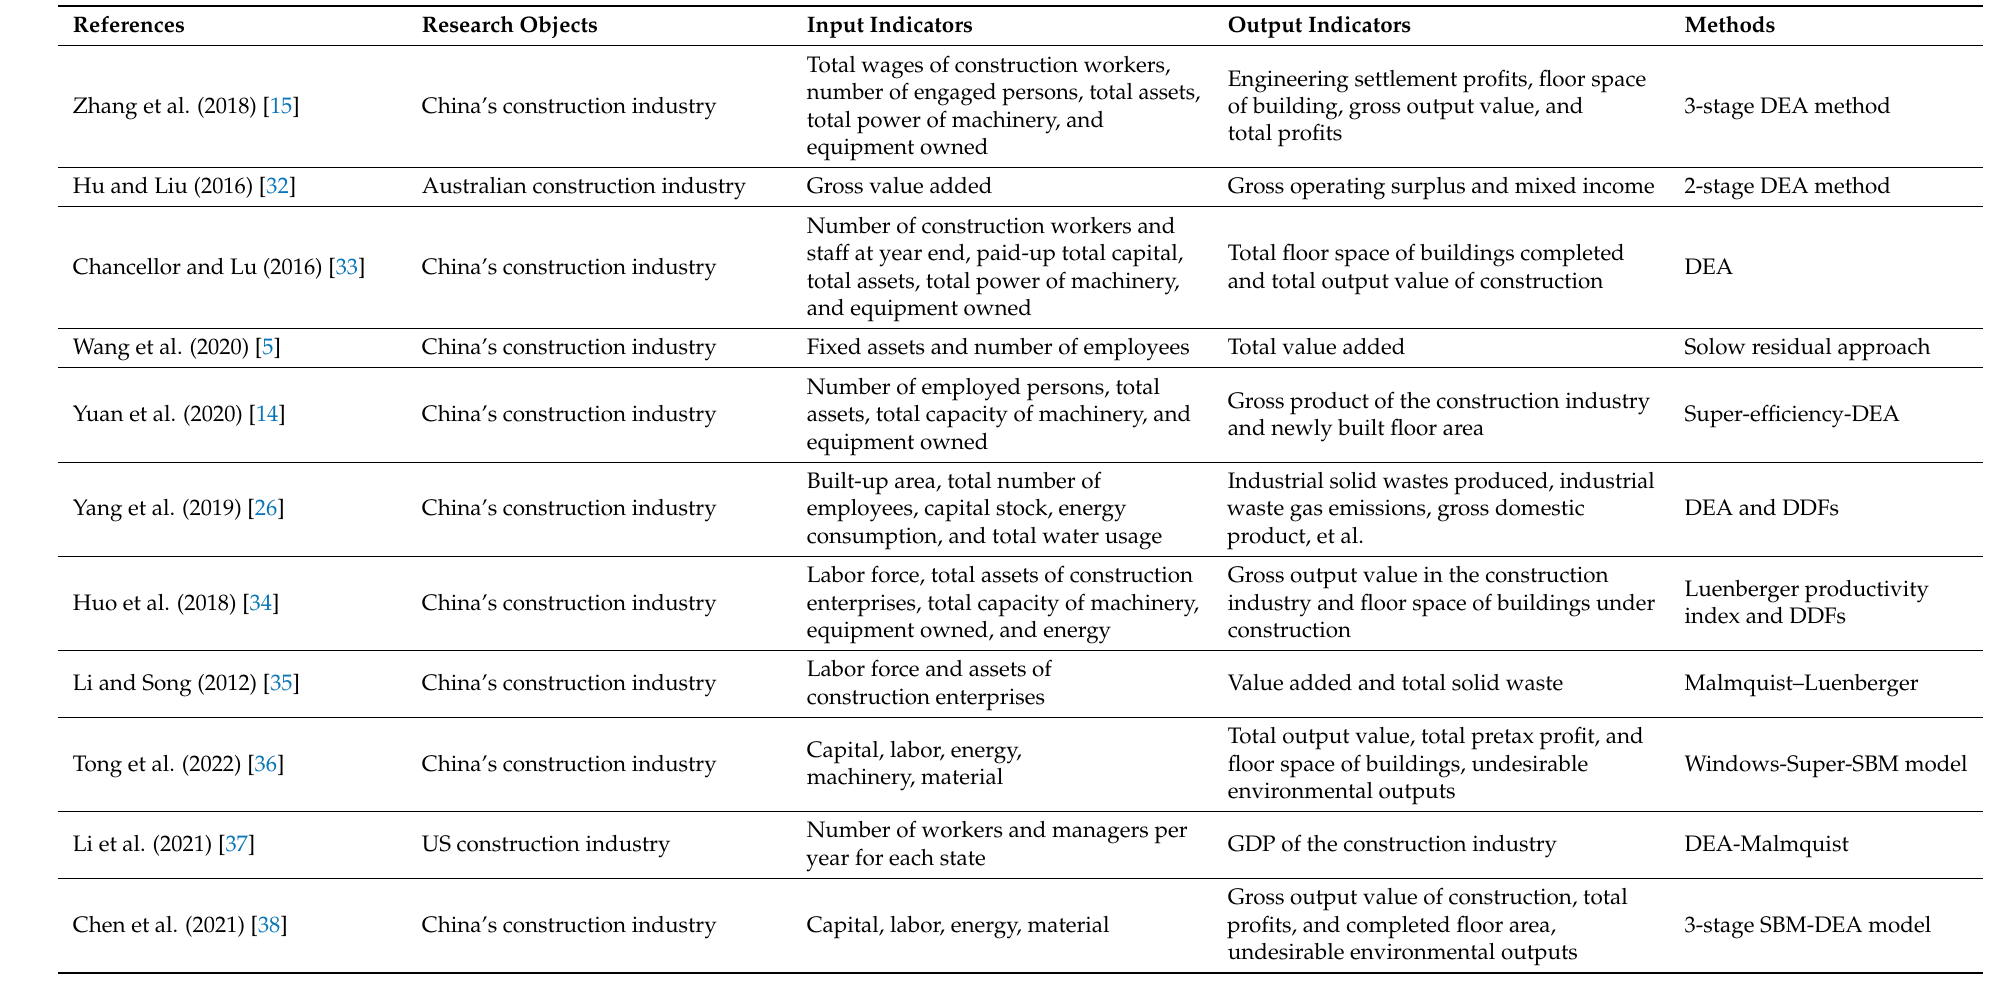
Table 1. Input and output variables of the construction industry obtained from the literature